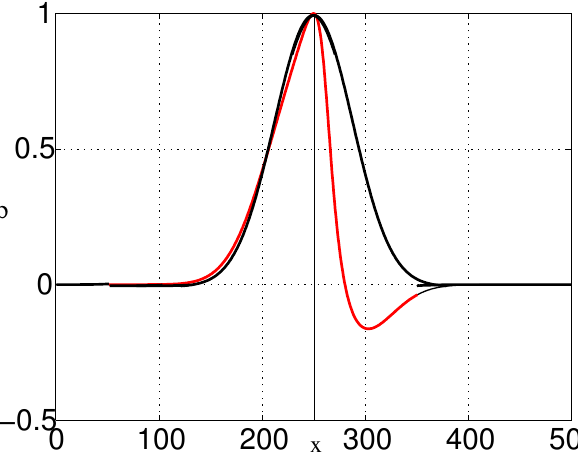
Fig. 4. Initial Gaussian background error covariance function (black curve) and anisotropic background error covariance function (red curve) from KF, at the observation